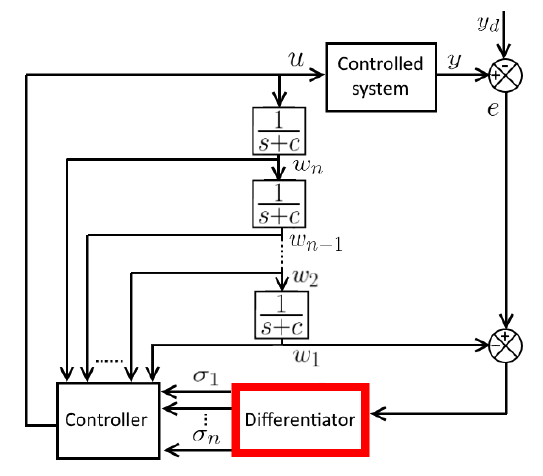
Figure 8. Block diagram of the closed-loop control system.